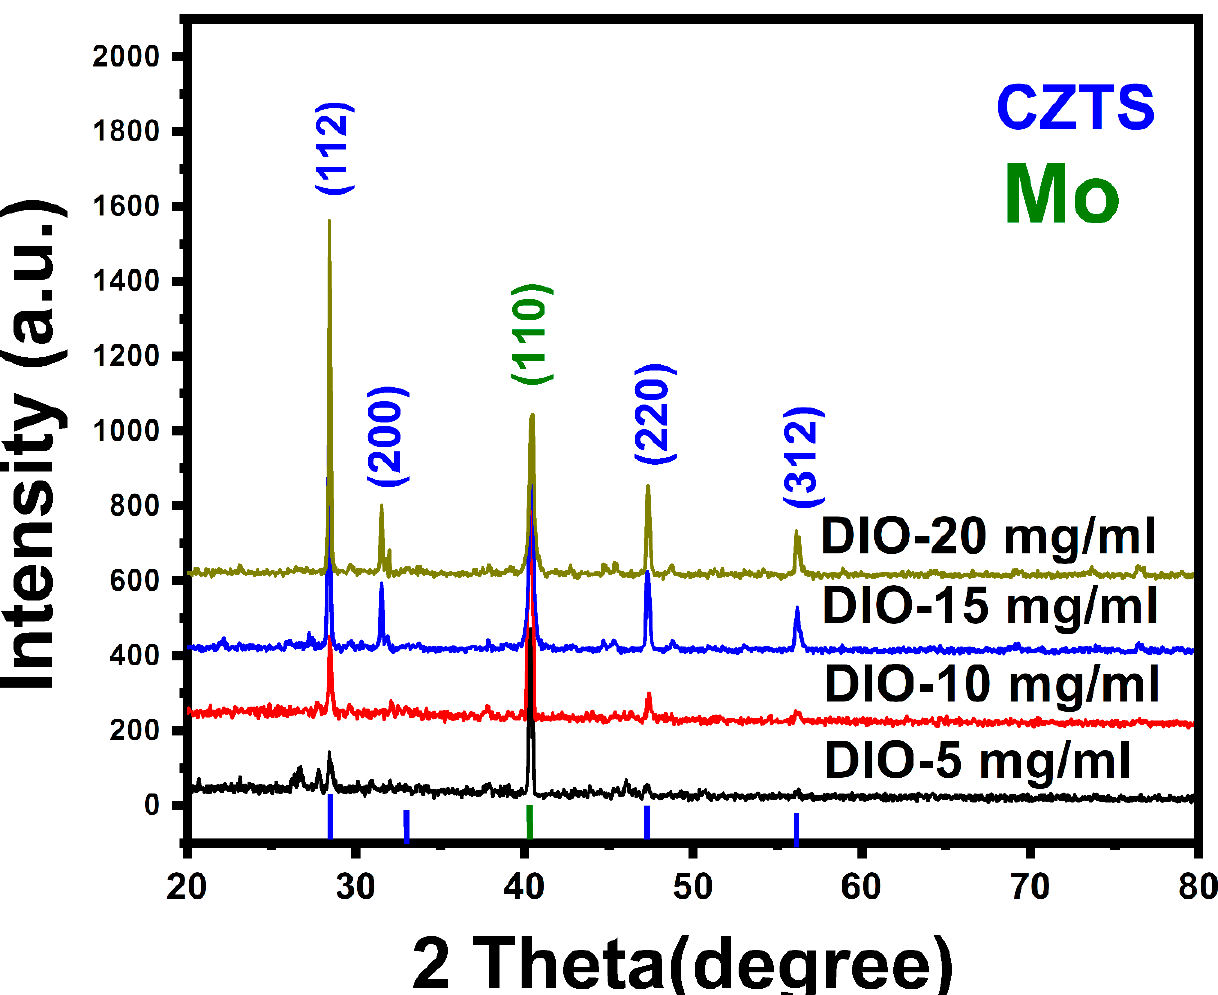
Figure 2. X-ray diffraction patterns of Cu 2 ZnSnS 4 (CZTS) samples annealed at 580 °C for 120 min and sulfurized with 200 mg S prepared using different 1,8-diiodooctane (DIO) additive concentra- tions.